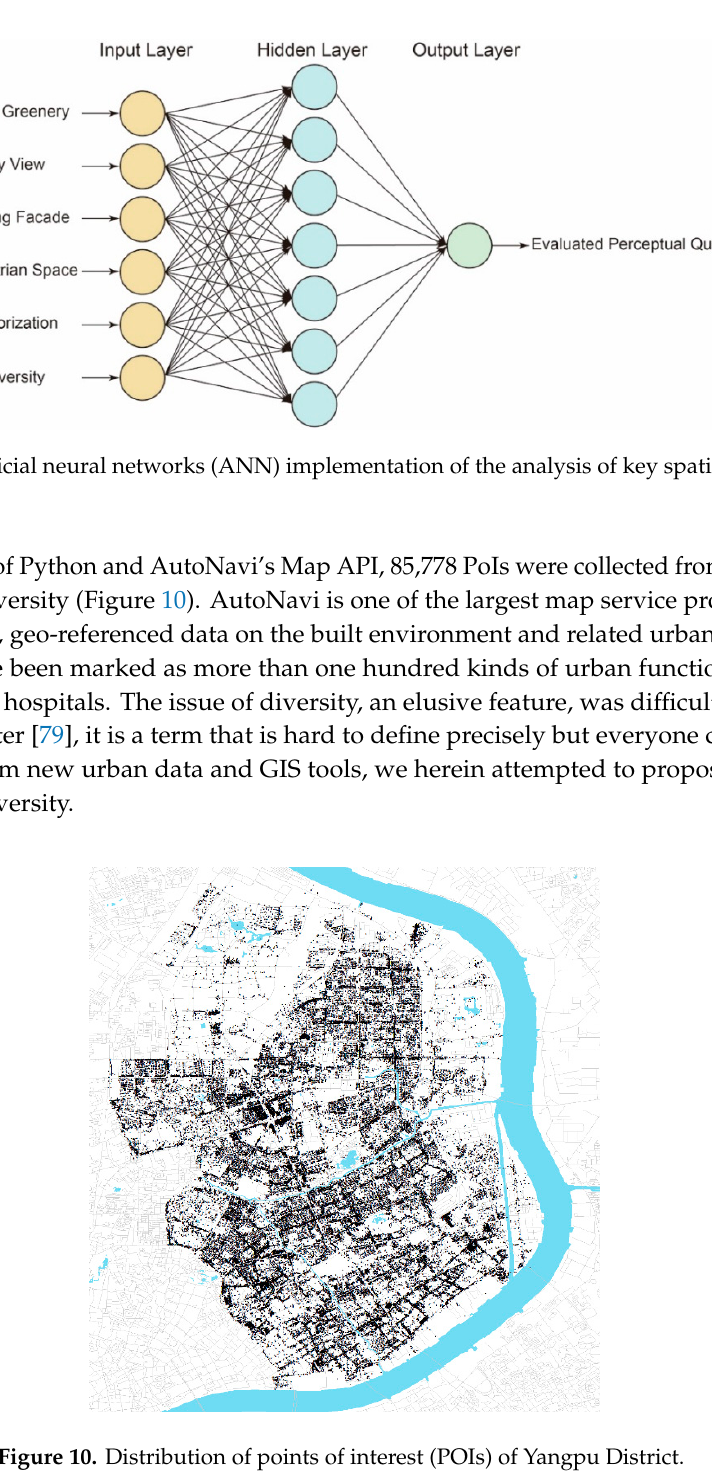
Figure 10. Distribution of points of interest (POIs) of Yangpu District.